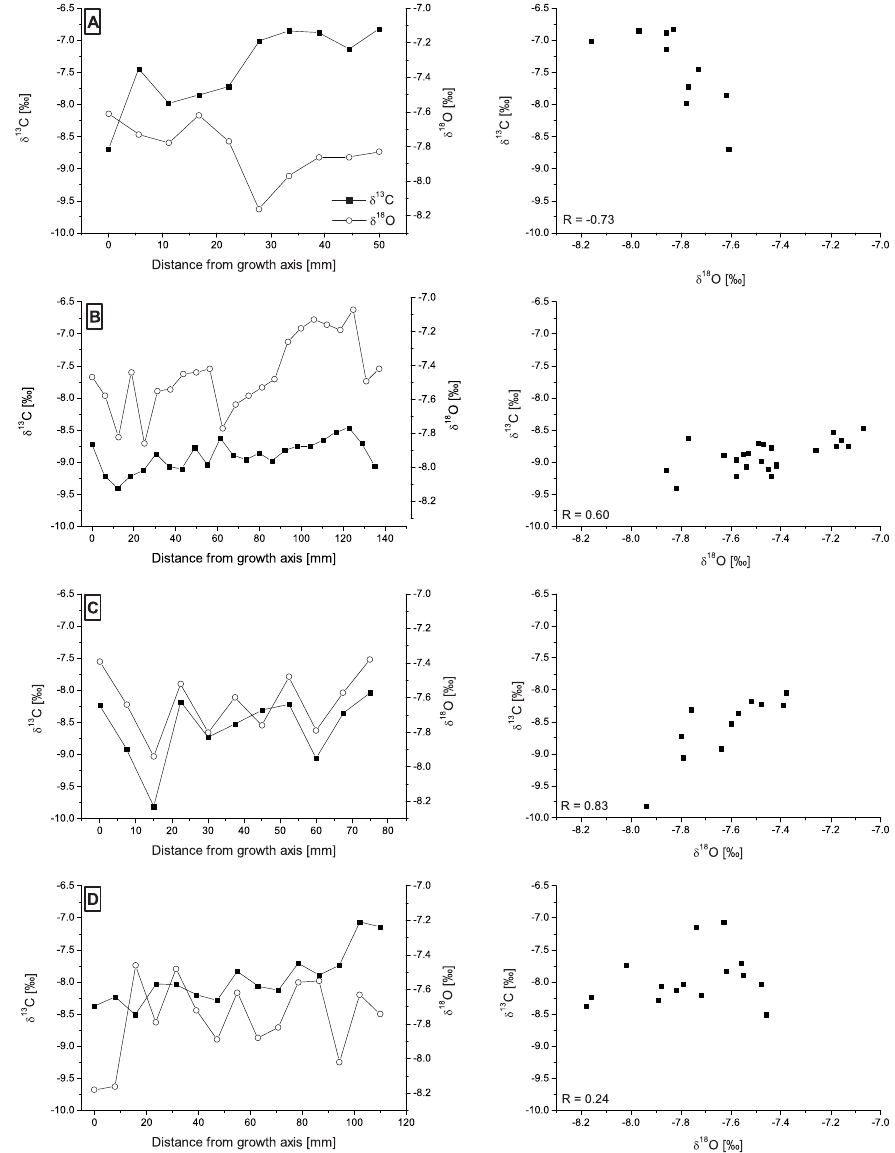
Fig. 6. Four “Hendy tests” for ER 76 conducted at 10, 50, 106 and 250mmdft (A – D) . The left side shows δ 18 O and δ 13 C values measured on a single growth layer plotted against the distance from the growth axis. Increasing values away from the axis are indicative of isotope fractionation under disequilibrium conditions. The right side shows the corresponding δ 13 C vs. δ 18 O plots. Kinetic isotope fraction is indicated by a positive